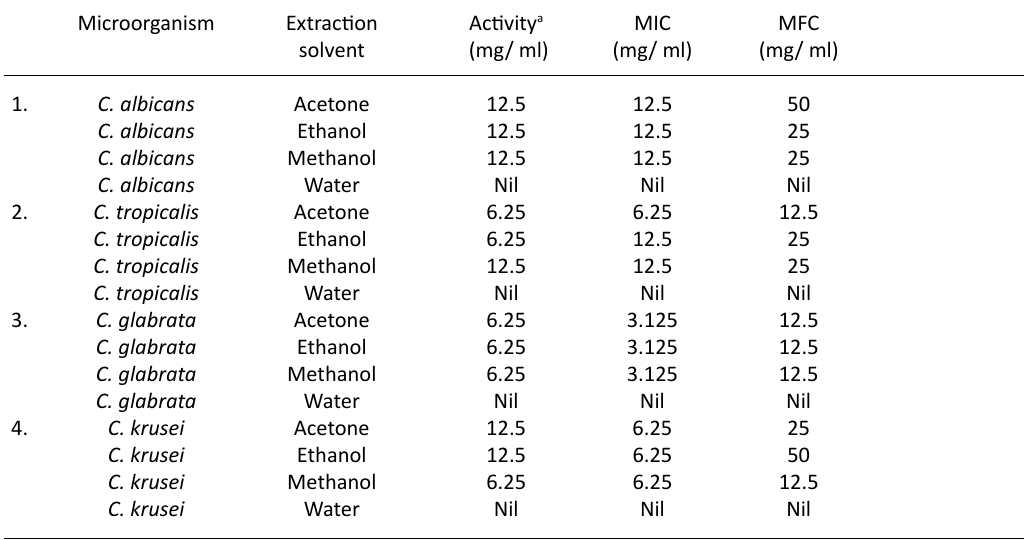
Table 3. Antifungal activity, minimum inhibitory concentration (MIC) and minimum fungicidal concentration (MFC) of acetone, ethanol, methanol and water extracts of Cyclamen persicum tubers on different pathogenic Candida